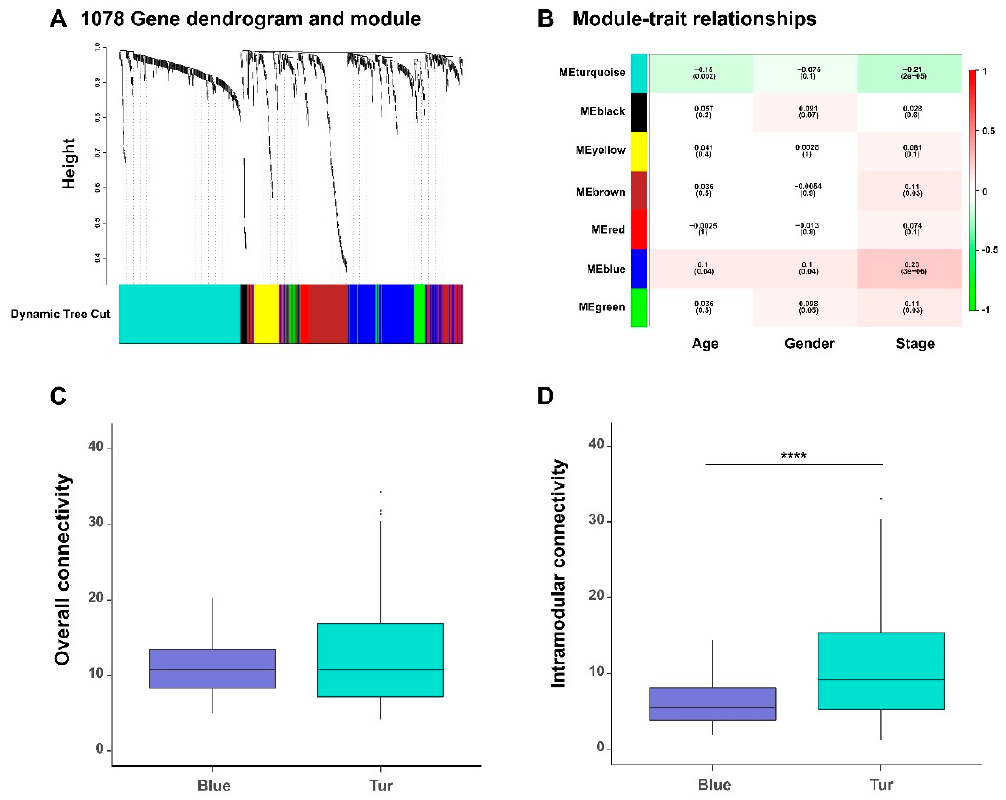
Figure 4. The functional modules of the gene co-expression networks detected by the weighted correlation network analysis (WGCNA) algorithm. ( A ) The hierarchical clustering tree (i.e., dendrogram) based on the dissimilarity scores and the individual gene clusters resulting from the dynamic tree cut algorithm. ( B ) The relationships between the module eigengenes (rows), which are defined as the first principal components of the gene expression profiles within individual modules, and the clinical traits (columns) of all BLCA patients. Each box shows the correlation coefficient and the corresponding p -value (in the bracket). The colors on the left represent individual functional gene modules, corresponding to those identified in ( A ). The comparison of the overall connectivity ( C ) and the intramodular connectivity ( D ) of members in blue and turquoise modules. **** p- value < 0.0001; two-sided Wilcoxon rank–sum test.